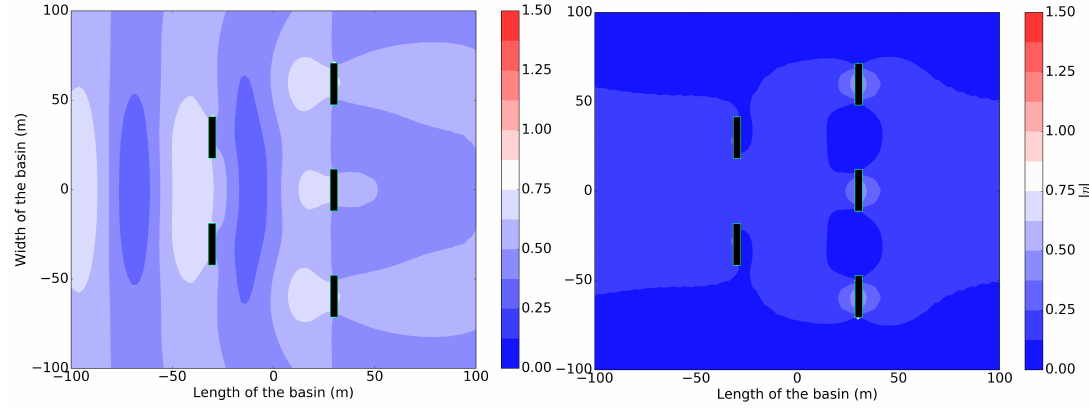
Figure 20. The total ( left ) and perturbed ( right ) | η | for an OSWEC for a wave of H = 1.0 m, T = 12.0 s for a linear PTO system. Incident wave propagating from the